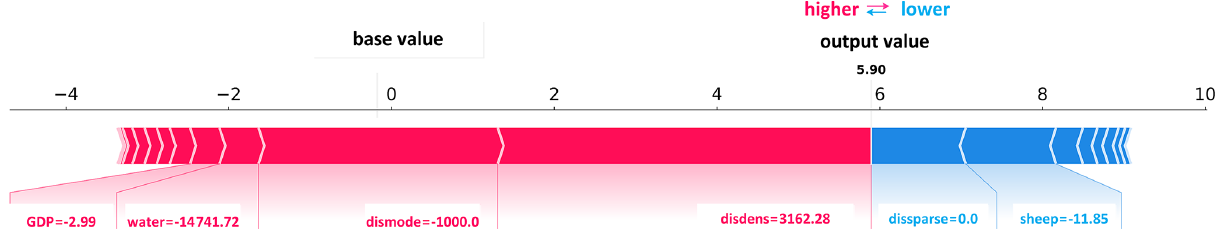
Figure 2. Decomposed SHAP values for the individual prediction of an example pixel. Table 2. Confusion matrix for binary classification of newly added grassland degradation (NGD) and other changes, including four indicators: false positives (FP), cells that were predicted as non-change but changed in the observed map; false negatives (FN), cells that were predicted as change but did not change in the observed map for disagreement; true positives (TP), cells that were predicted as change and changed in the observed map; and true negatives (TN), cells that were predicted as non-change and did not change in the observed map for agreement. Observed values Others NGD Simulated values